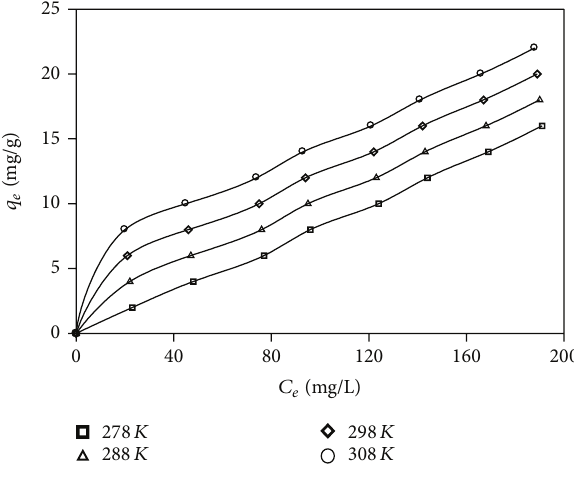
Figure 4: Effect of temperature on the adsorption of 3,5-xylenol onto asphaltene. Table 4: Adsorption thermodynamic parameters of xylenols adsorption onto